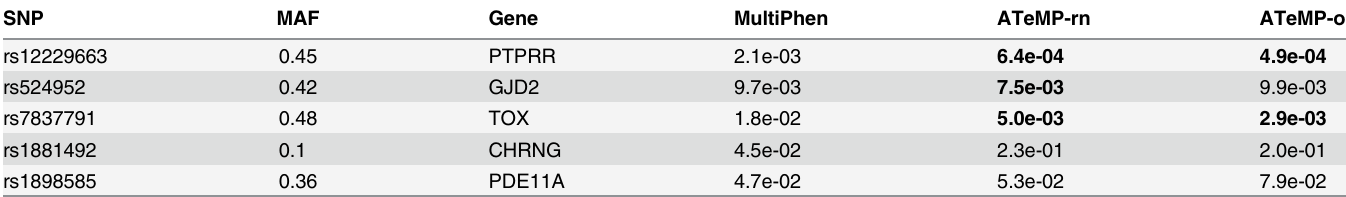
Table 3. P-values from association tests of jointly analyzing CYL and SPH. The bold-face texts highlight where ATeMP tests may be superior to MultiPhen.